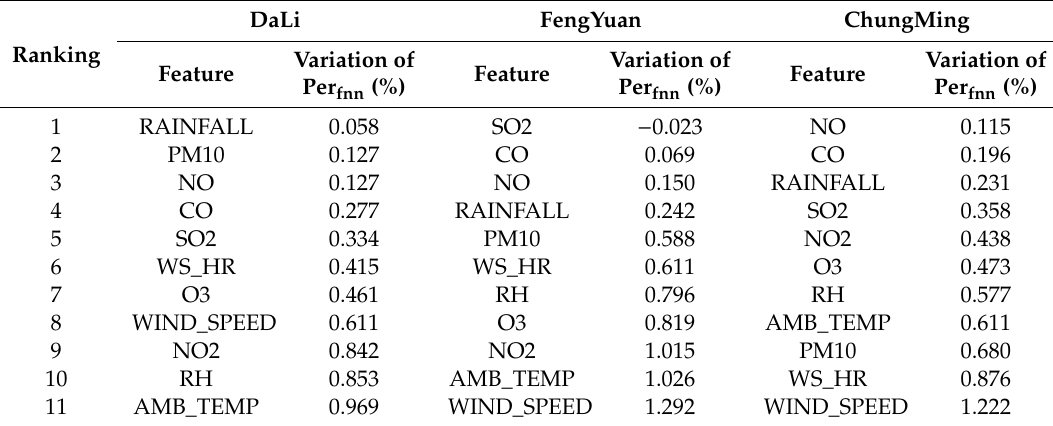
Table 3. Features ranked by importance using the modified false nearest neighbor method (MFNNM) in three locations.